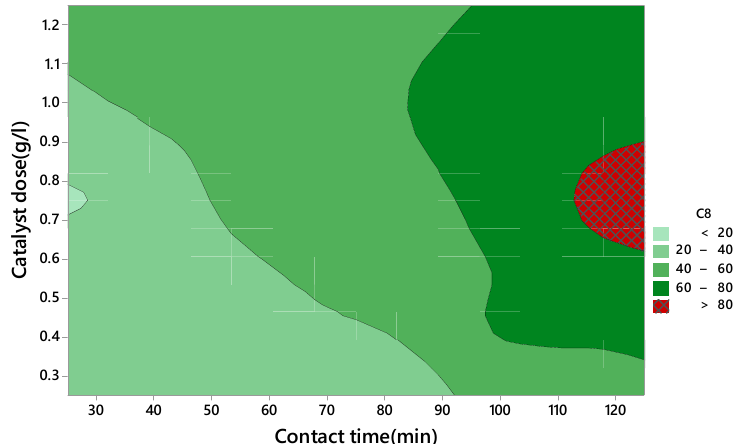
Fig. 7. Effect of pH on degradation of Acid Red 18 using TiO Table 6. Optimum conditions in the removal of AR18. Parameters Unit Value catalyst concentration g/L 0.88 contact time min 125 pH - 6.5 Predicted AR18 removal % 98.5 Experimental AR18 removal % 96.3